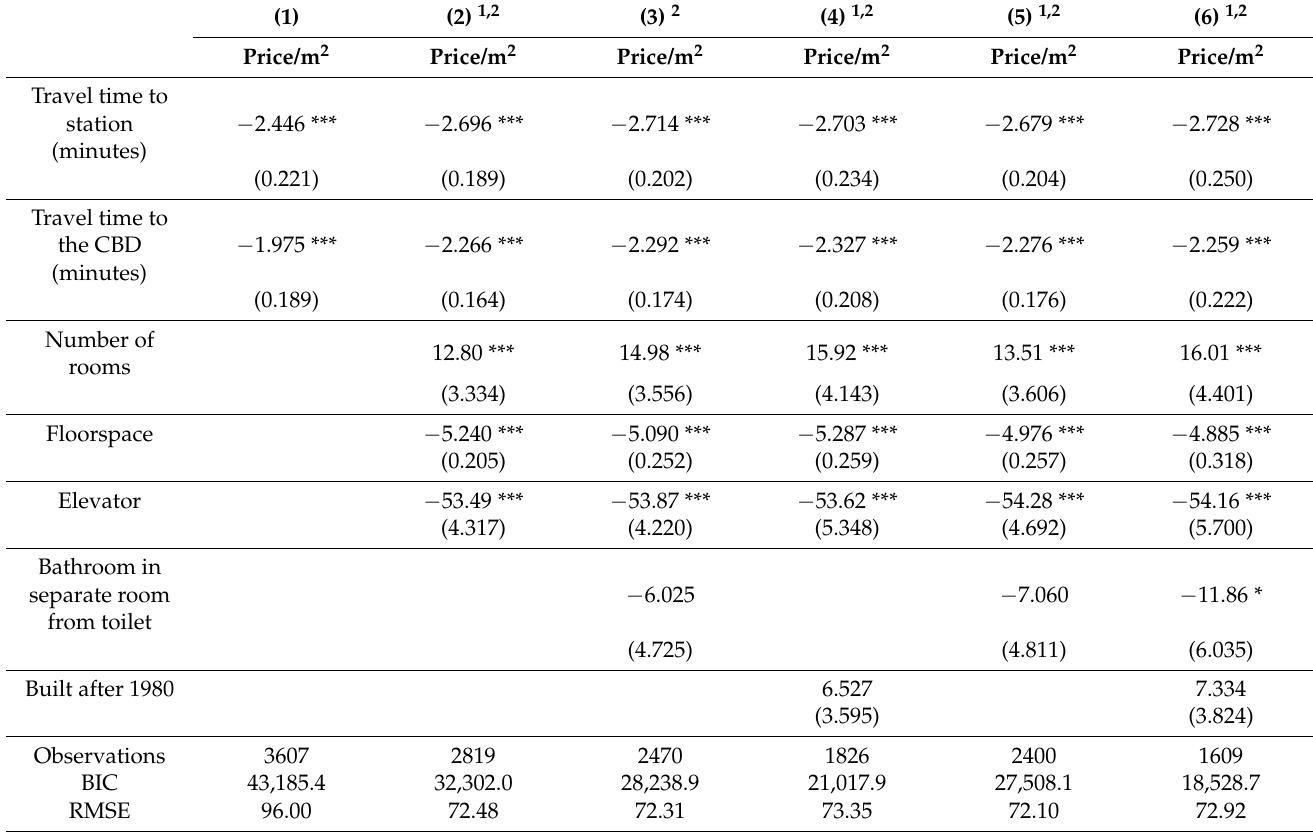
Figure 9. Floorspace plotted against travel time to the CBD. Table 2. Regression results for panel flat attributes’ impacts on